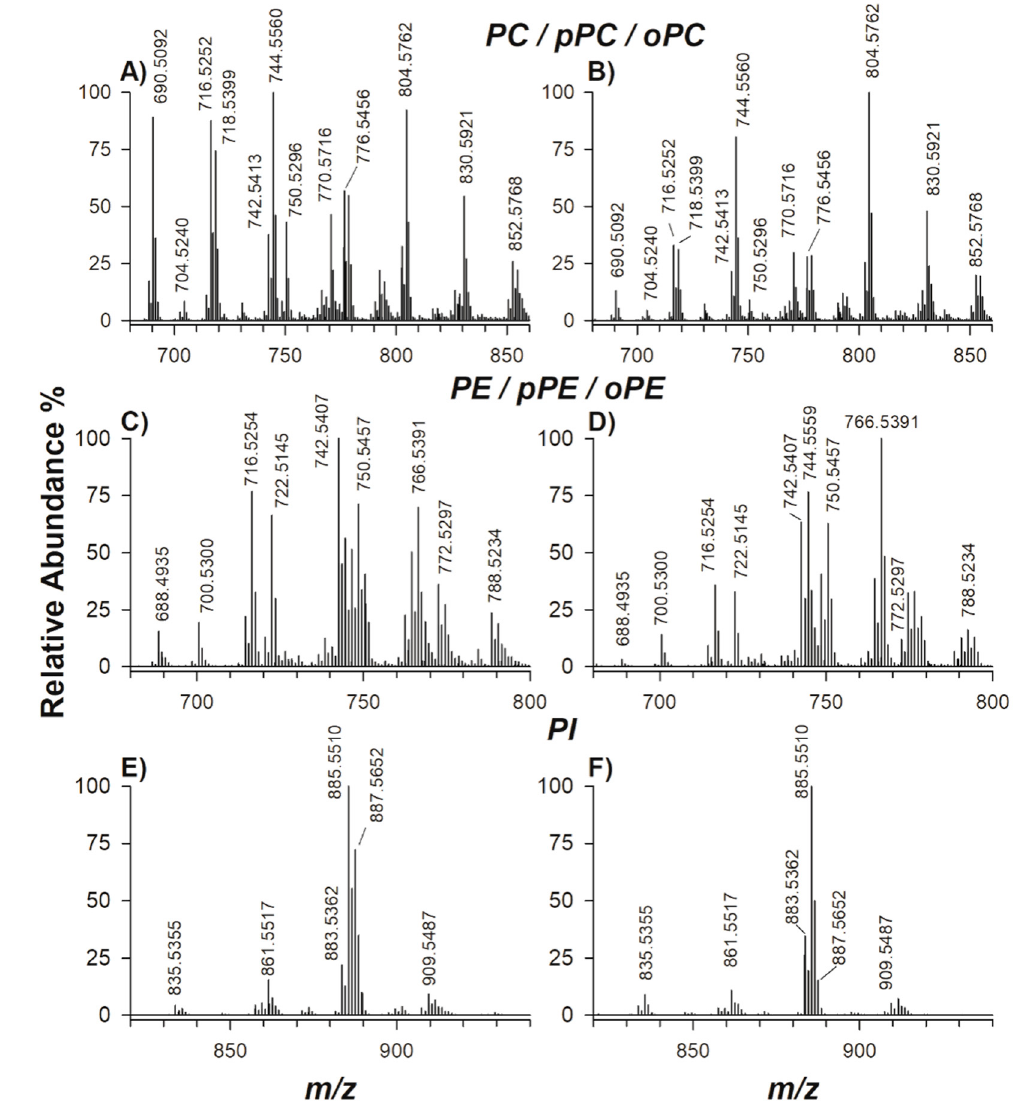
Figure 2. Fourier transform mass spectrometry (FTMS) spectra relevant to phosphatidylcholines (PC), phosphatidylethanolamines (PE) and phosphatidylinositols (PI) in negative ion mode averaged under the chromatographic bands of fibroblast lipid extract relevant to control cells ( A , C , E ) and PD patient with ex2del/ex4del deletion ( B , D , F ).